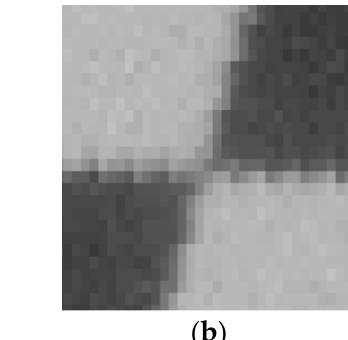
Figure 5. The mean extraction error of corner points at different noise levels. For a real calibration image, there is an inevitable gradual change at the black-and- white boundary due to manufacturing reasons. Therefore, the noise level at corner areas is relatively higher than that at homogenous areas. For estimating the extraction accuracy of corner points, small areas around corner points were intercepted from the simulation calibration image and the real calibration image as shown in Figure 6. According to previous studies of image noise estimation [22–24], the noise level of the acquired real calibration image at corner areas is equal to the simulation calibration image with 35 DB Gaussian noise. Therefore, the extraction accuracy of corner points for our setup is about 0.2 pixels. The calibration error caused by the image noise is simulated as shown in Figure 7. In the simulation, the calibration plate, the square of the calibration plate, the image size was set to 100 × 100 mm, 5 × 5 mm and 1000 × 1000 pixel, respectively. The extraction error of 0.2 pixels was set to random different directions, and then the mean calibration error was calculated.